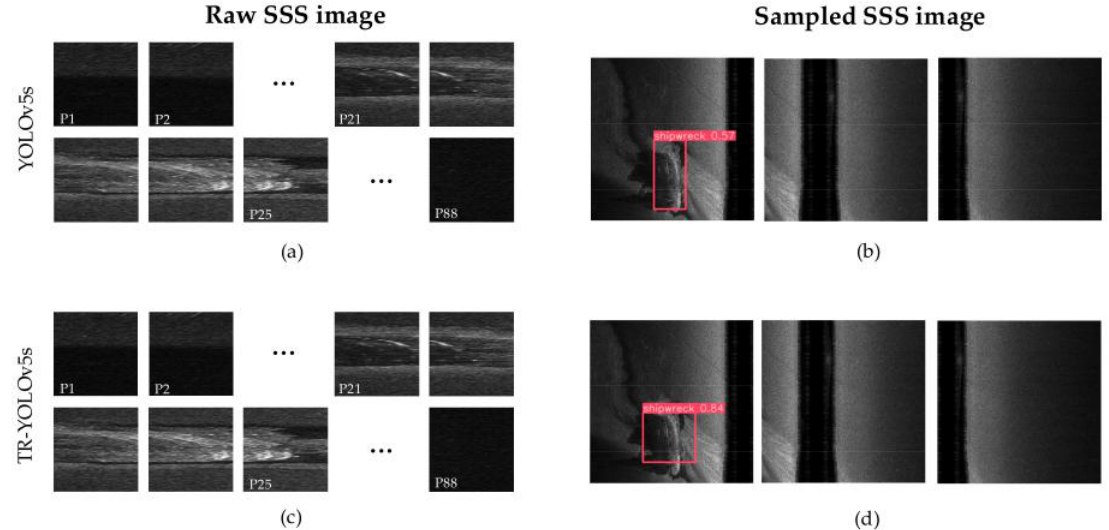
Figure 21. Detection results for SSS image in Figure 20: ( a ) the detection result of raw SSS image by YOLO5s; ( b ) the detection result of sampled SSS image by YOLOv5s; ( c ) the detection result of raw SSS image by TR–YOLOv5s; ( d ) the detection result of sampled SSS image by